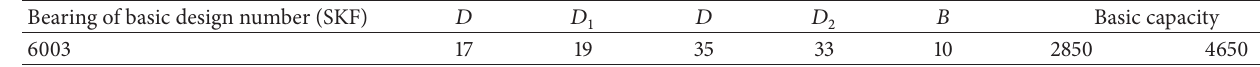
Table 7: Selection of coupler shaft bearing series 60.